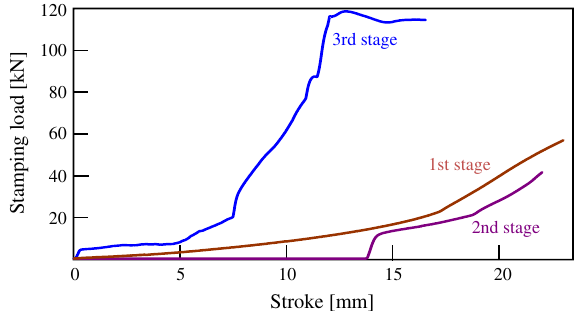
Figure 8. Forming conditions in (a) 3rd stage and (b) 2nd stage to improve thickening of two corners. Figure 9. Stamping load-stroke curve for h = 45 (cid:3) and s